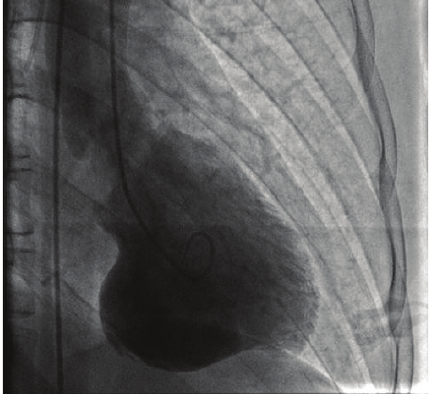
Figure 2: Left ventriculography with contrast showing left ventric- ular